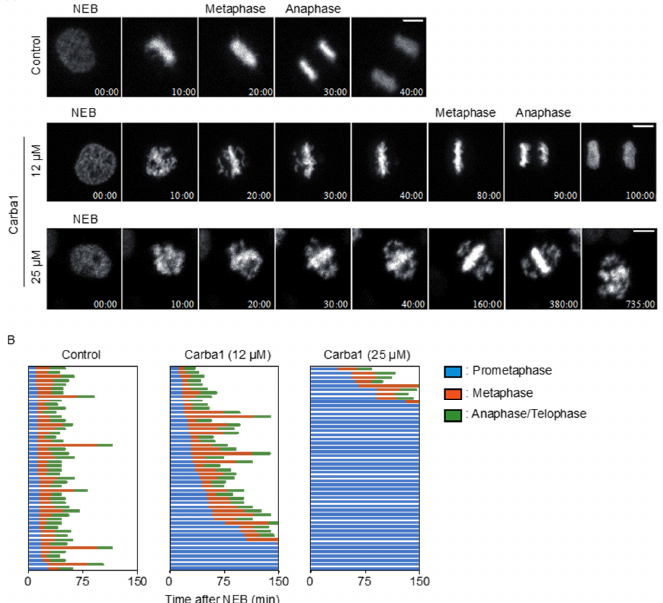
Figure 3. Carba1 induces a mitotic arrest. ( A ) Representative images, selected from Movie S1 of HeLa Kyoto cells treated with DMSO (control) and the indicated concentrations of Carba1. Bar = 10 µ m. ( B ) Analysis of the duration of mitosis in HeLa Kyoto cells treated with DMSO (control) or with different doses of Carba1, as indicated. Duration of prometaphase (from nuclear envelope breakdown (NEBD) to chromosome alignment; blue), metaphase (from chromosome alignment to anaphase onset; orange) and anaphase / telophase (from anaphase onset to chromosome decondensation; green) were analyzed from Movie S1. The data represent 50 cells for each